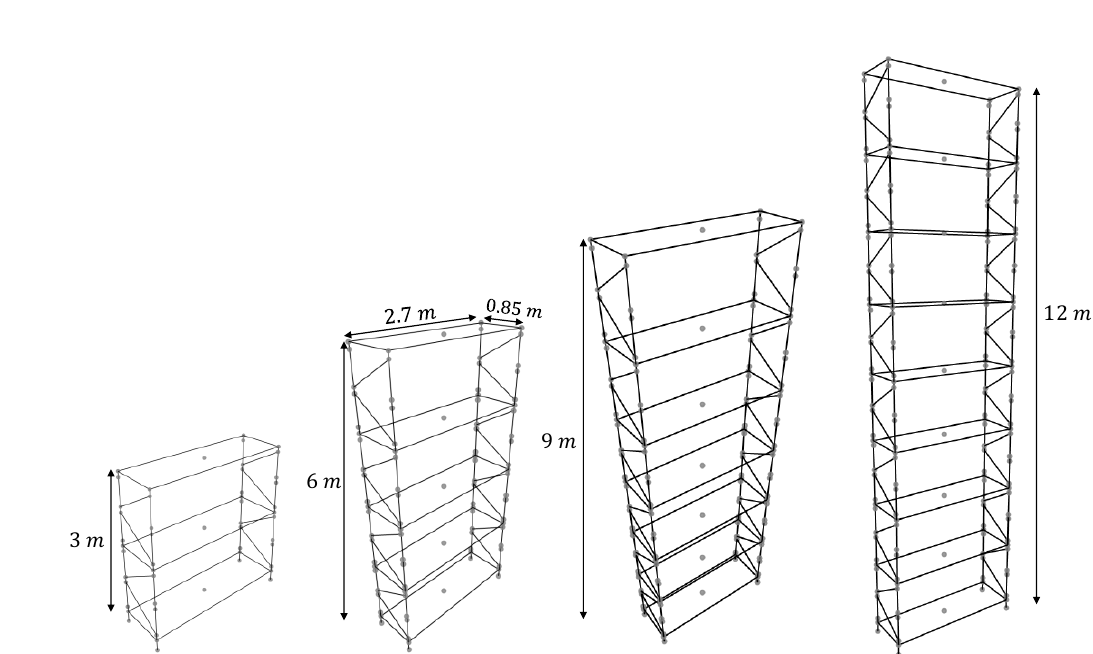
Figure 1. Basic structuring of each level of the racks analyzed.